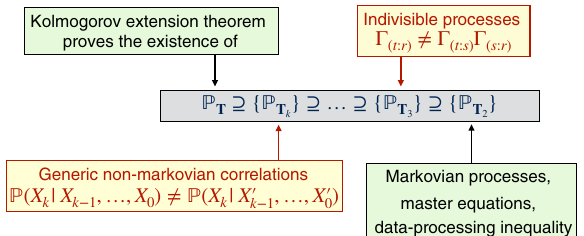
FIG. 6. Hierarchy of multitime processes. A stochastic process is the joint probability distribution over all times. Of course, in practice one looks only at finite-time statistics. However, the set } contain, as marginals, of all k -time probability distributions { P T k } for j < k . Moreover, the all j -time probability distributions { P T j set of two and three time distributions plays a significant role in the theory of stochastic